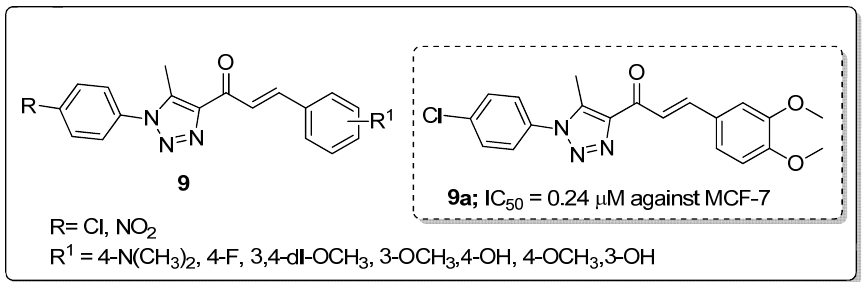
Figure 11. Most active anticancer agent chalcone conjugate with 1,2,3-triazole 9a .